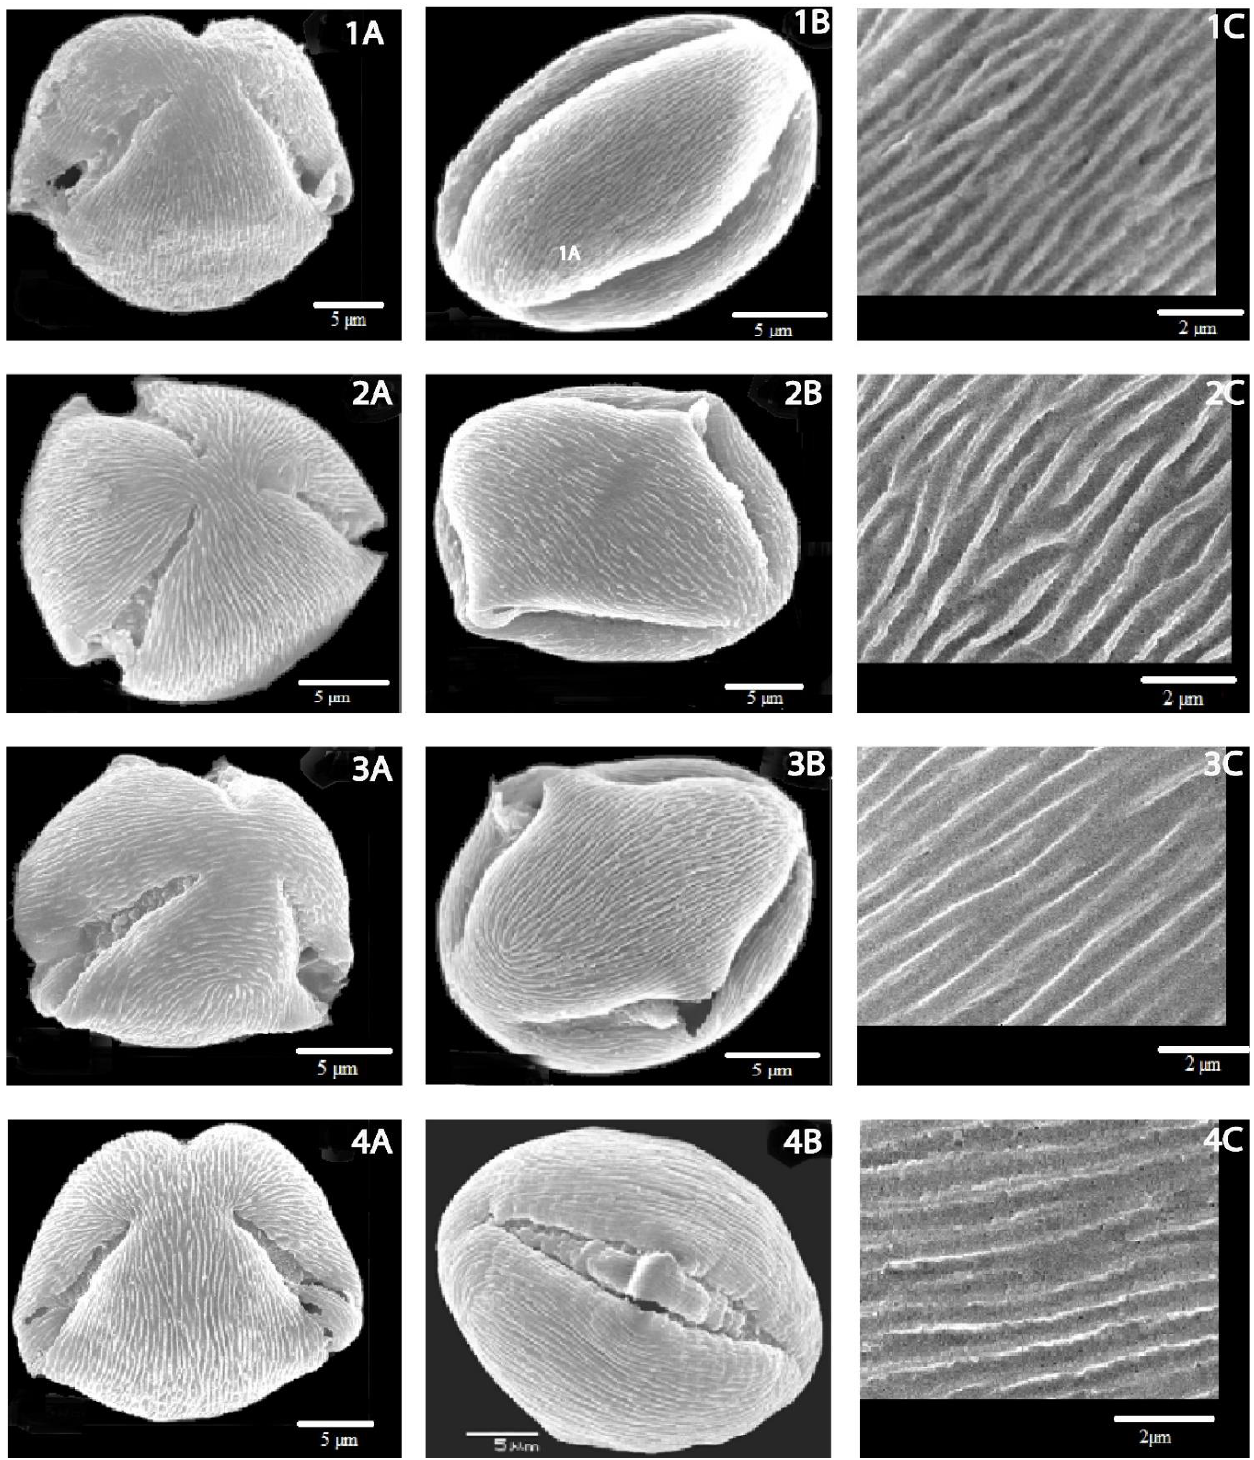
Figure 2. ( A , B ). Different shapes of pollen ( C ). surface 16639-( 1A – 1C ) R. omeiensis , 16692- R. sericea , 16692-( 2A – 2C ) R. omeiensis , 16785-( 3A – 3C ) R. mairei , 16677-1-( 4A – 4C ) R. sikangensis .